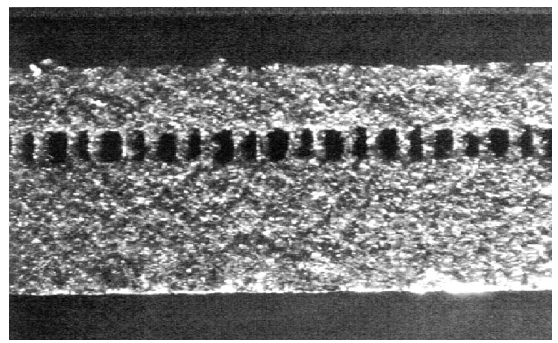
Fig. 2. Photomicrograph of AAVID